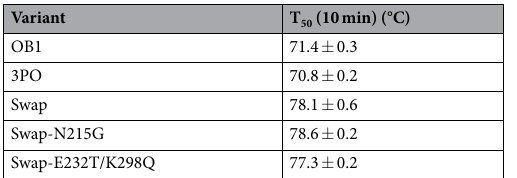
Table 1. T 50 (10 min) values for parent-type laccases (OB1 and 3PO), domain-swap laccase (swap) and variants of domain-swap laccase obtained by site-directed mutagenesis.